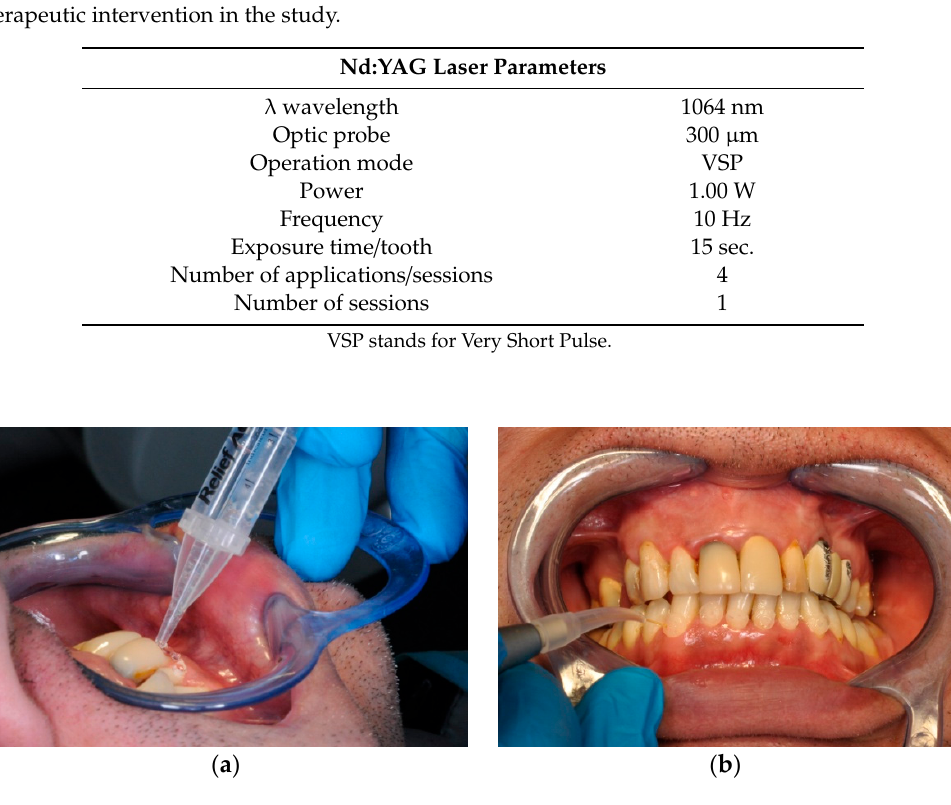
Figure 2. Treatment application: ( a ) desensitizing gel in the cervical vestibular area; ( b ) Nd:YAG laser radiation, directly through the gel, on a tooth in the fourth quadrant.